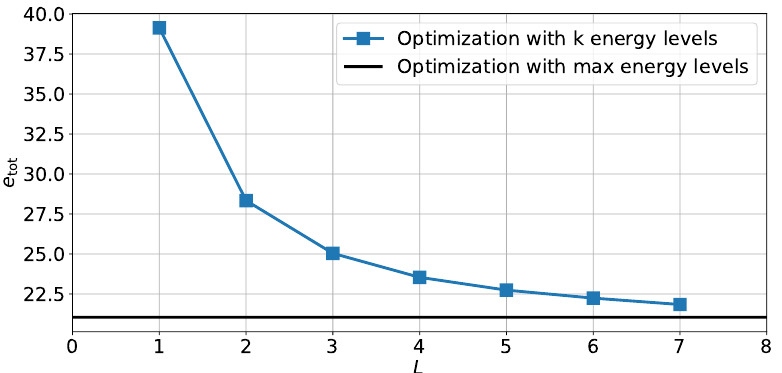
Figure 8. Energy needed to store a variable in memory e tot for different values of energy level available L to achieve a fixed covariance